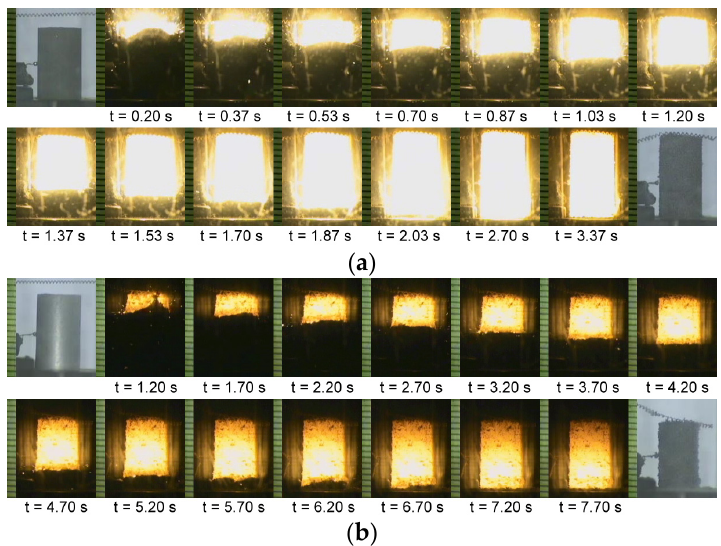
Figure 1. Self-propagating combustion images recorded from Reaction (1): ( a ) x = 2 and ( b ) x = 6.